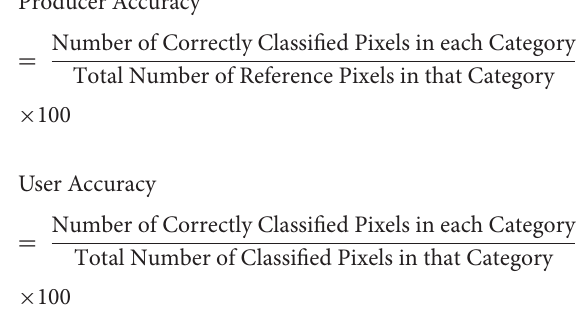
number of correctly classified pixels in each category by the total number of classified pixels in that category (Pal and Ziaul,